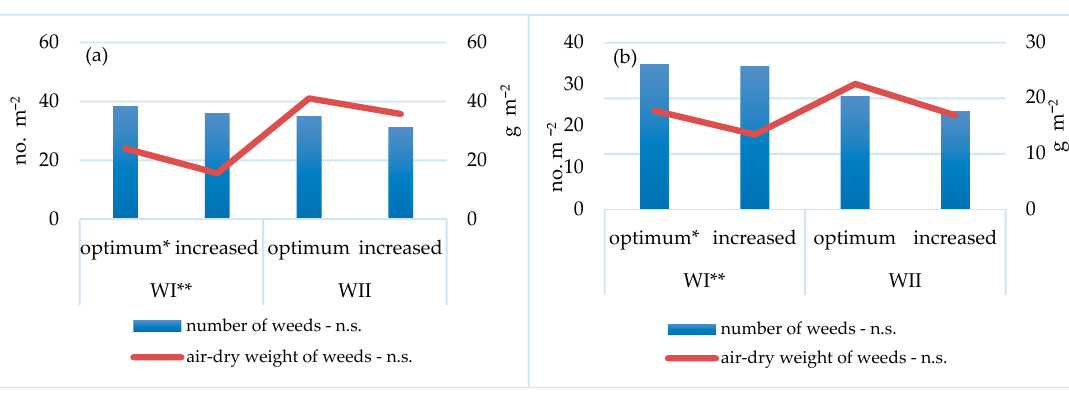
Figure 1. The impact of seeding density on weed infestation indicators in the spelt wheat cultivars “Rokosz” ( a ) and “Schwabenspelz” ( b ) (mean for 2013–2015). Note: * seeding density, **WI—number and air-dry weight of weeds 3–4 weeks after herbicide treatment, WII—number and air-dry weight of weeds at the dough stage of spelt wheat (BBCH 83–85), n.s.—not significant differences.